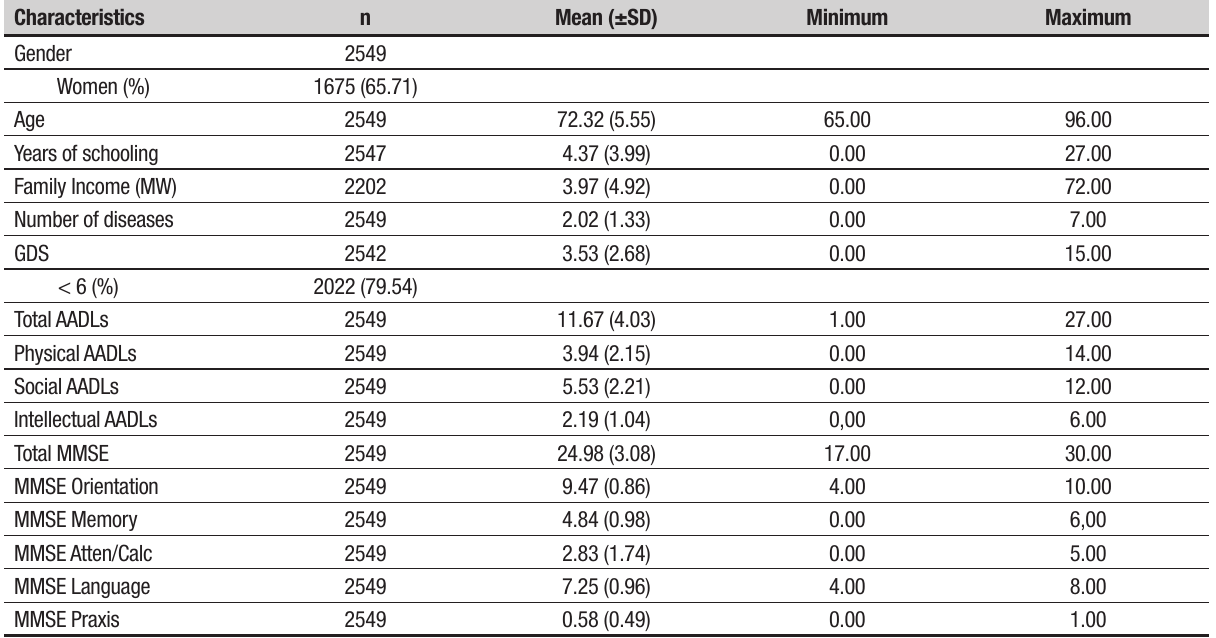
Table 1. Means and standard deviations for sociodemographic variables, number of diseases reported, depressive symptoms, AADLs and cognitive performance. FIBRA study, Unicamp, 2008-2009.